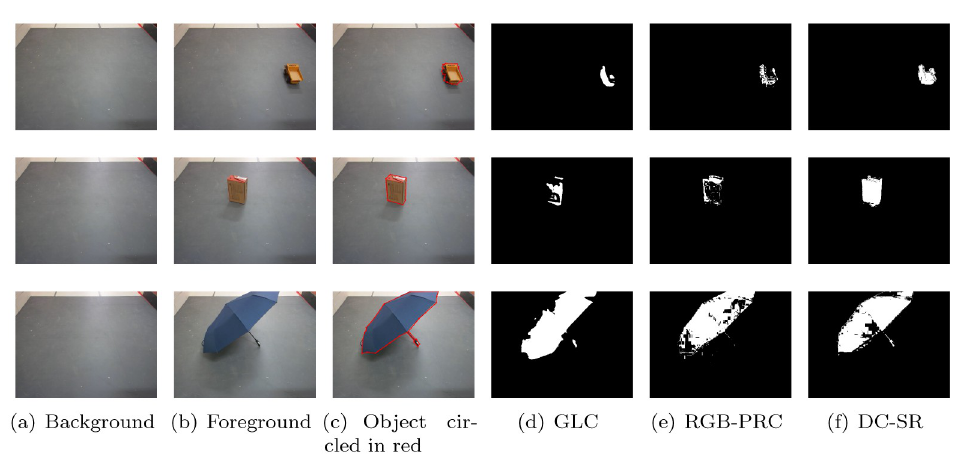
Fig 5. Comparison of shadow removal with GLC, RGB-PRC and DC-SR methods, respectively, in indoor environments. (a) Background (b) Foreground (c) Object circled in red. (d) GLC. (e) RGB-PRC. (f) DC-SR.